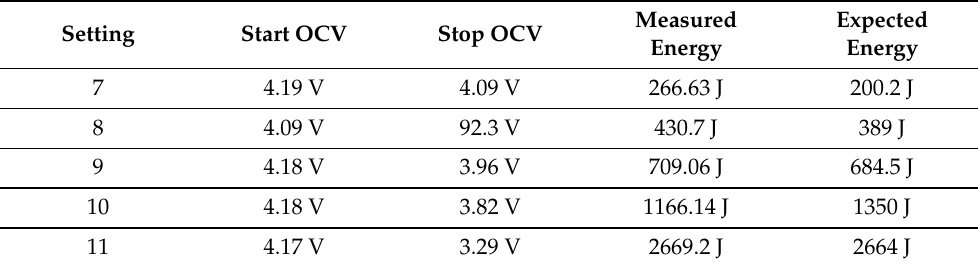
Measured Energy